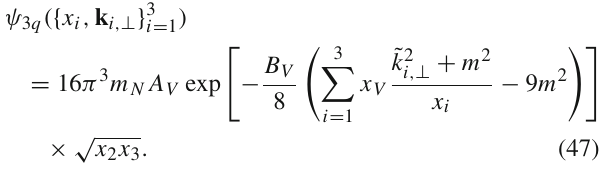
function within the above described prescription can be